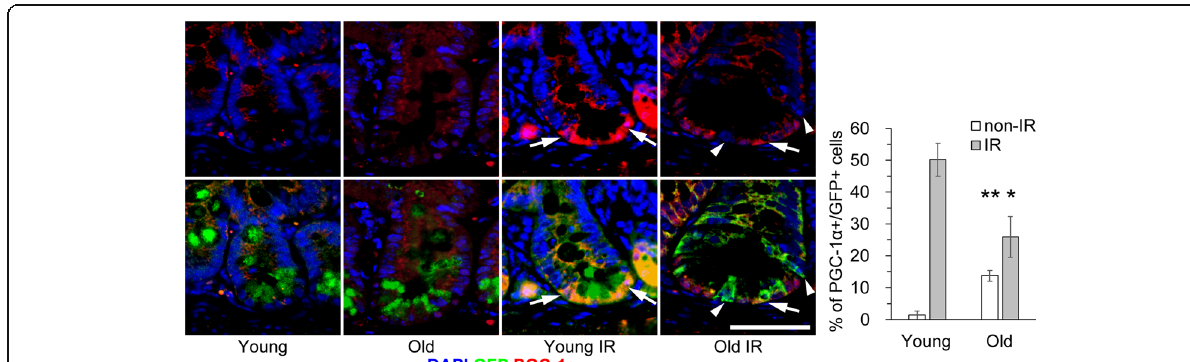
Fig. 3 DDR-dependent mitochondrial biogenesis is decreased in old ISCs. Immunohistochemical analyses of PGC-1 α were performed in young and old jejunum with (IR) or without 10 Gy X-ray irradiation (non-IR). Representative images stained with an anti-PGC-1 α antibody, together with a graph of the percentage of positive cells, are shown. Arrows and arrowheads indicate GFP and PGC-1 α double-positive and GFP single-positive cells, respectively. Data are mean ± s.e.m. ( n = 3 and > 100 GFP+ cells). * p < 0.05. Scale bar, 50 μ m